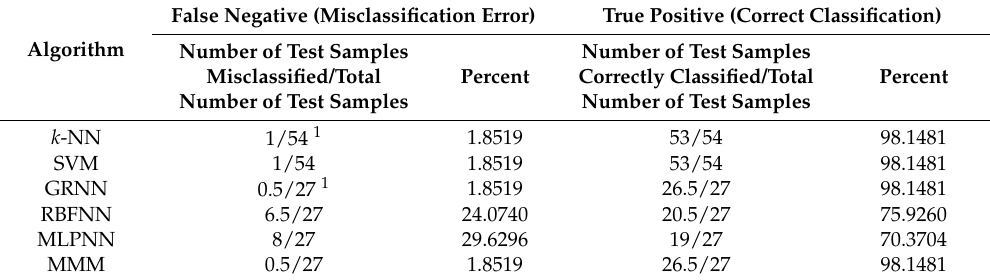
Table 3. Misclassification error and correct classification rate of the classification algorithms during testing with validation and test data set from trained classes, i.e., banana, sapodilla, and pineapple each at three ripeness states, with nine classes in total. Results are averaged over 10 simulations. In the table k -NN, SVM, GRNN, RBFNN, MLPNN, and MMM are abbreaviated forms of k -nearest neighbor, support vector machine, generalized regression neural network, radial basis function neural network, multilayer perceptron neural network, and minimum-maximum-mean, respectively.